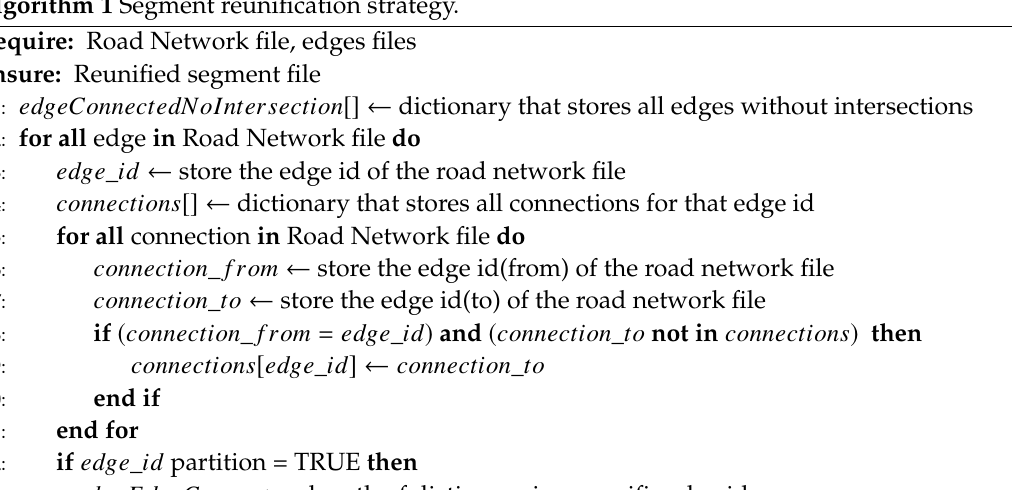
Algorithm 1 Segment reunification